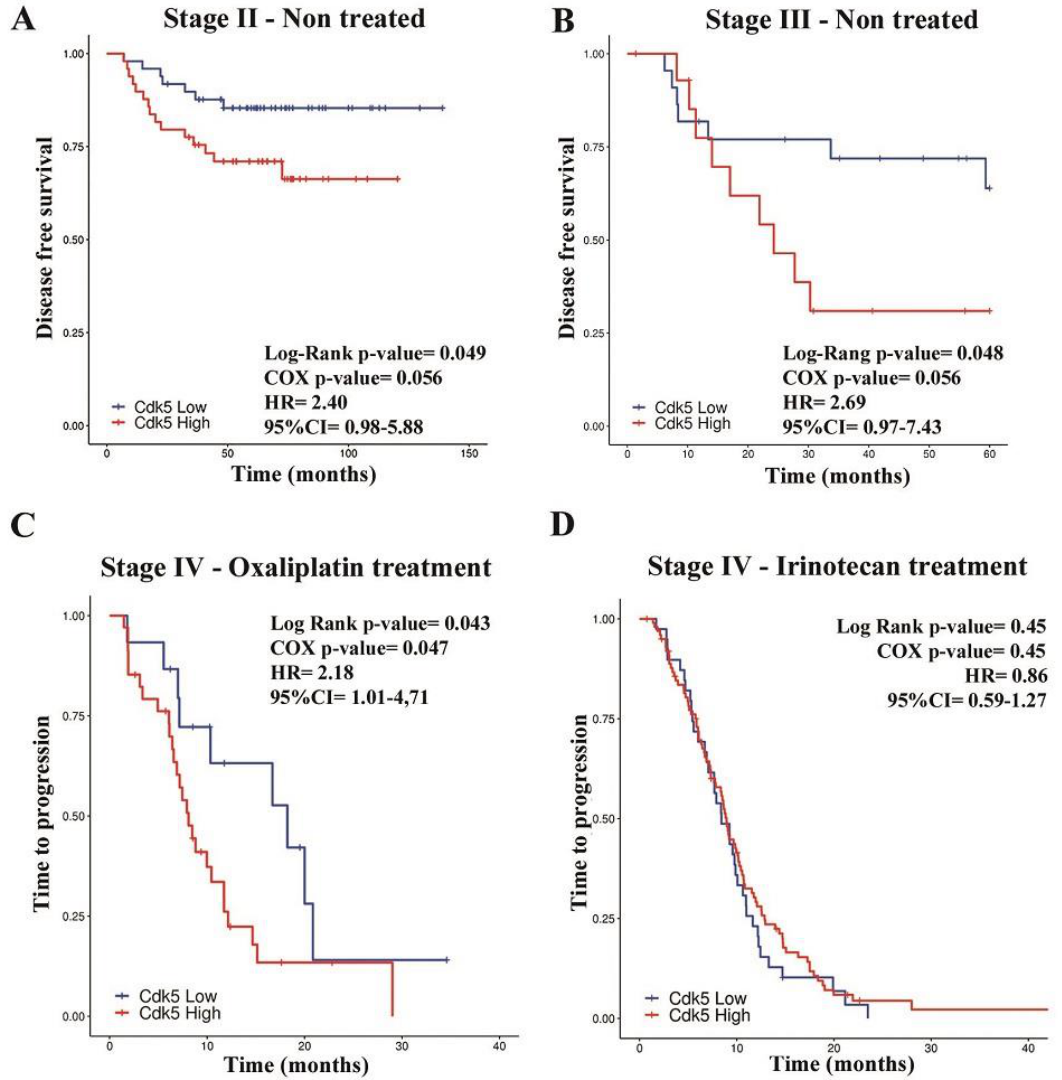
Figure 4. Kaplan–Meyer analysis of disease free survival (DFS) and time to progression (TTP) depending on Cyclin dependent kinase (Cdk5) levels. ( A ) DFS in 98 stage II colorectal cancer (CRC) patients split by the median of Cdk5 expression (cohort B). ( B ) DFS in 37 non-treated stage III CRC patients split by the median of Cdk5 expression (cohort C). ( C ) TTP in 52 stage IV oxaliplatin-treated patients, grouped depending on negative ( n = 18) or positive Cdk5 ( n = 34) immunohistochemistry (IHC) staining (cohort D). ( D ) TTP in 139 stage IV irinotecan-treated patients grouped depending on negative ( n = 73) and positive ( n = 66) Cdk5 IHC staining (cohort E).